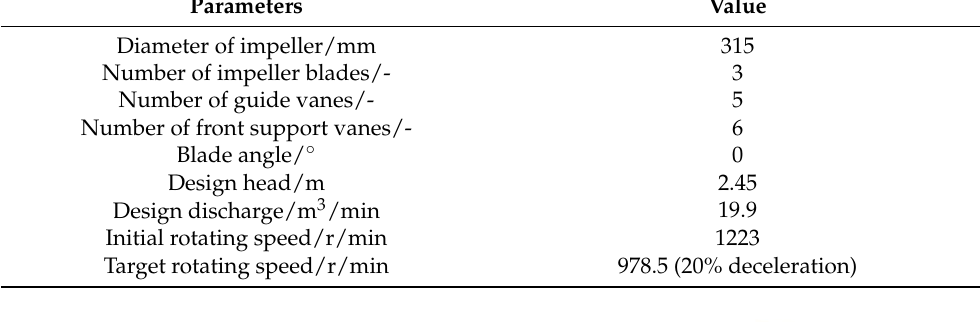
Table 1. Characteristic parameters of pump model flow system.